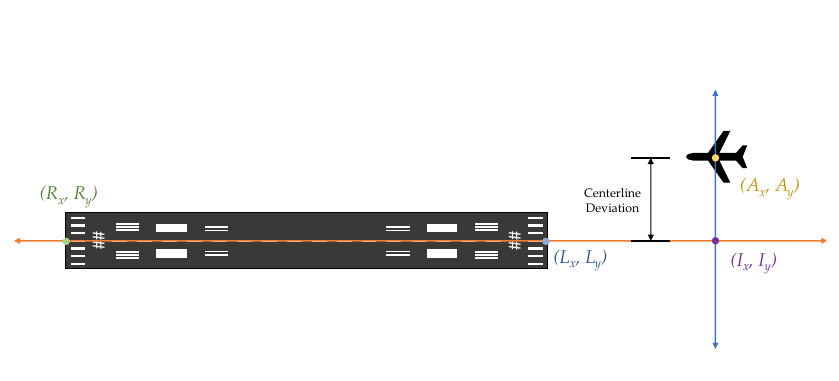
Figure 3. Visualization of the procedure applied to calculate the centerline